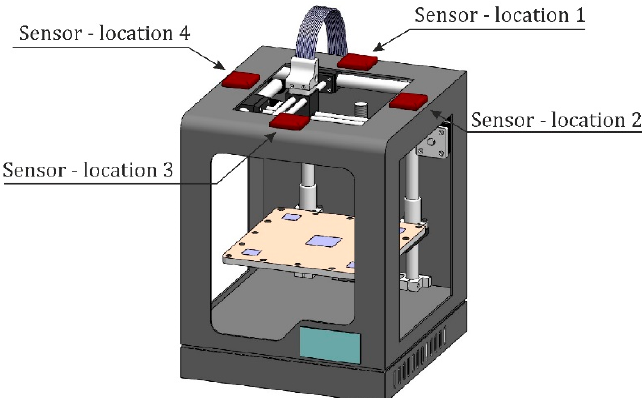
Figure 5. The LIS2DH accelerometer module—real test system. Figure 4. The checked locations of the accelerometer on the printer housing. Figure 4. The checked locations of the accelerometer on the printer housing.